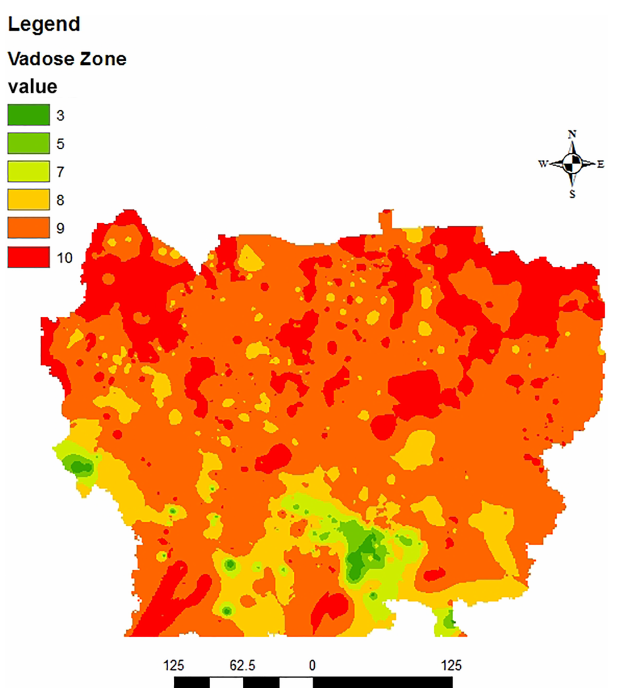
Figure 6. Vadose zone distribution map.